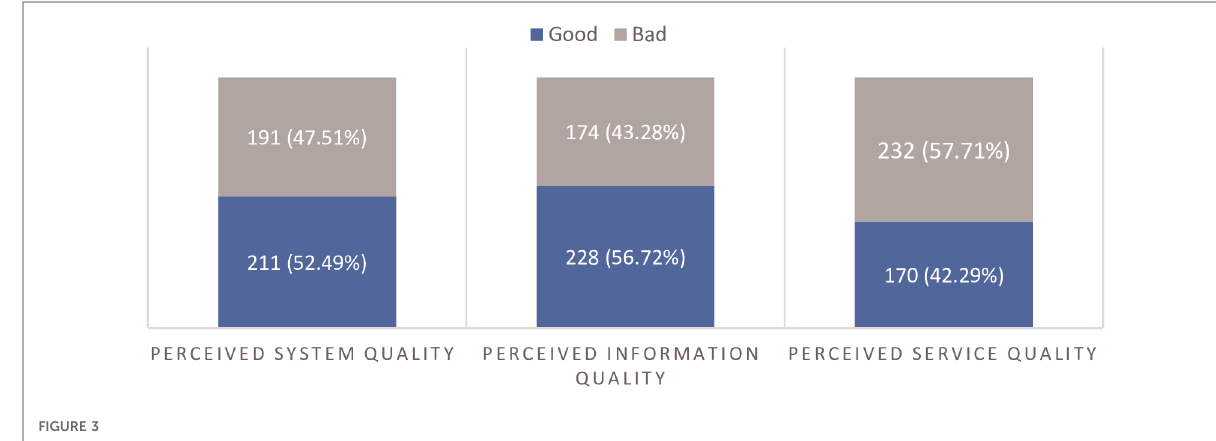
FIGURE 3 Study participants ’ perceived EMR system, information, and EMR service quality, Dire Dawa, Ethiopia, 2019.